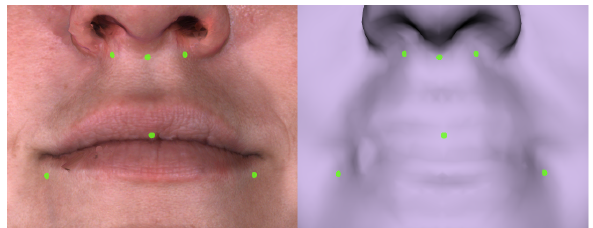
Figure 7. Incorrect placement of mouth landmarks on the participant’s face (left) due to poor non-rigid registration of the mouth (right) without causing measurement error in the labial fissure